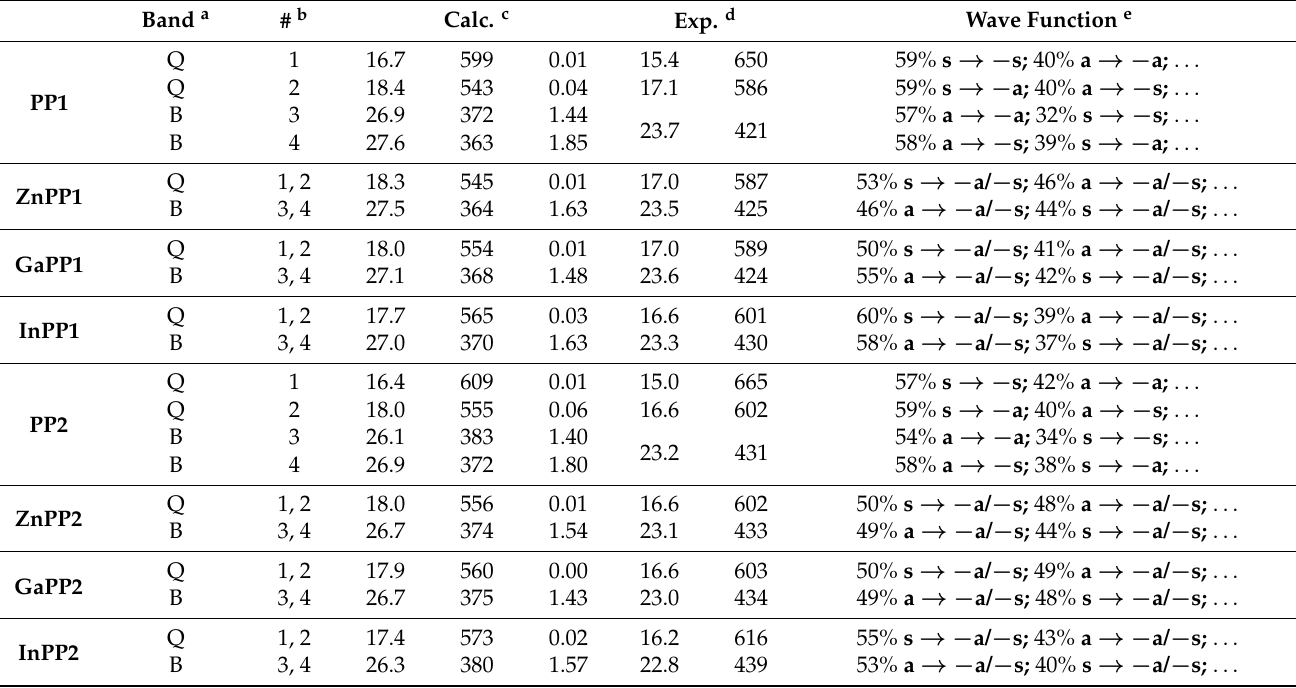
Table 3. Electronic excitation bands of the synthesized porphyrins at the TD-DFT level of theory using the CAM-B3LYP functional with either SDD or 6-31G(d) basis